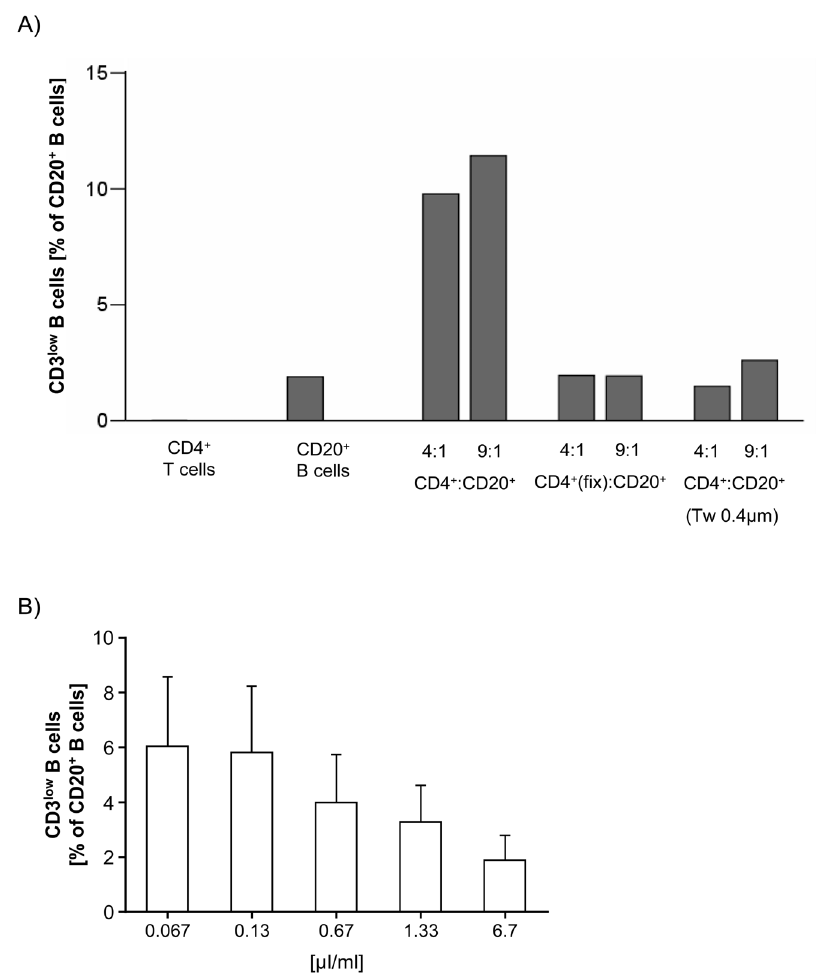
Figure 5. Transfer of CD3 from T to B cells requires cell-cell contact and is impaired by monensin treatment. (A) Shown are numbers of CD3 low CD20 + B cells in one patient after co-culture of MACS-purified CD4 + T cells and CD20 + B cells overnight (oN) at 4 u C. While CD3 low CD20 + B cells were found to be elevated with increasing T-B cell ratios, fixation of antigens on the T cell surface using 1% PFA before co-culture with B cells oN at 4 u C did prevent CD3 acquisition by CD20 + B cells. Moreover, co-culture of CD4 + T cells and CD20 + B cells using transwell (Tw) chambers (pore size of 0.4 m m) prevented the appearance of CD3 low CD20 + B cells, excluding the possibility that membrane vesicles like exosomes transfer T cell surface markers from T to B cells. (B) The occurrence of CD3 low CD20 + B cells after oN storage of blood samples at 4 u C was impaired by the addition of monensin (applied by the protein transport inhibitor BD GolgiStop). Shown are the results of four independent experiments.